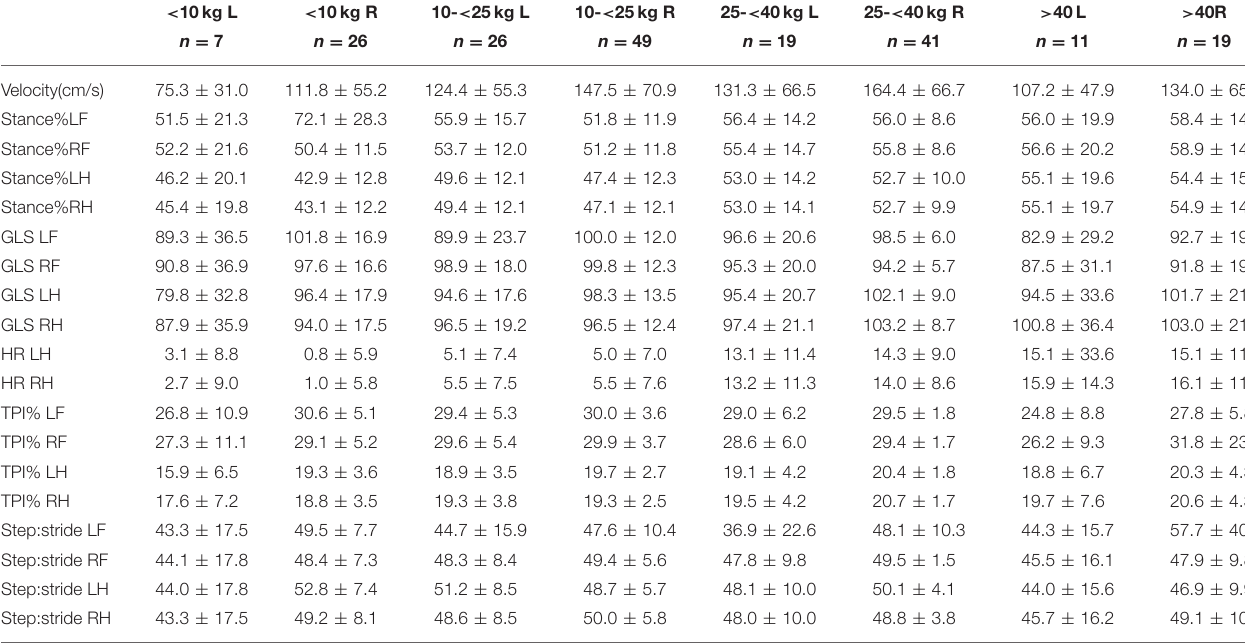
TABLE 1 | Data at the walk expressed as mean ± standard